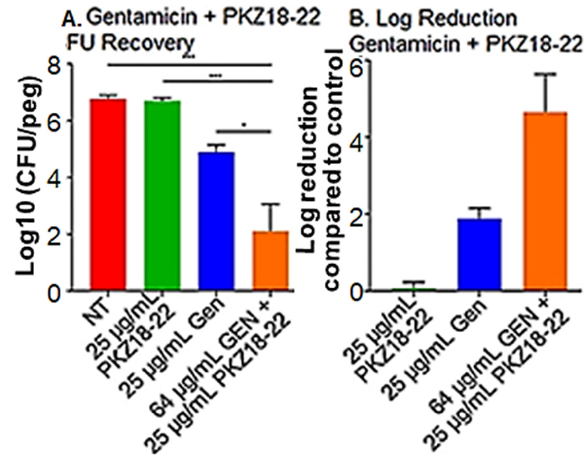
Figure 4. PKZ18-22 plus gentamicin inhibition of biofilms. ( A ) S. aureus biofilm CFU/log10 after 24 h of a single dose gentamicin, PKZ18-22, and the combination of gentamicin and PKZ18-22. The following asterisk values using a Student’s t -test indicate: * indicates p < 0.05; *** indicates p < 0.001. ( B ) After a single dose 24 h challenge, the combination of gentamicin/PKZ18-22 resulted in a cell reduction of ~5 logs, >99.9%. A significantly greater reduction when compared to each treatment alone.